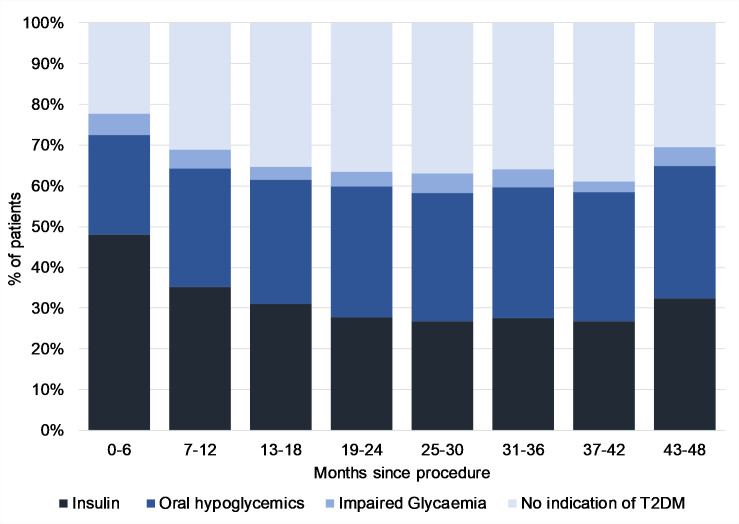
T2DM status in patients over time since bariatric procedure.Percentage of patients with each T2DM status among those with a follow-up visit during each time period from bariatric procedure. Numbers at each visit were the following: month 0 to 6 n = 2,150; month 7 to 12 n = 1,446; month 13 to 18 n = 1,114; month 19 to 24 n = 639; month 25 to 30 n = 633; month 31 to 36 n = 251; month 37 to 42 n = 190; month 43 to 48 n = 108. T2DM, type 2 diabetes mellitus.